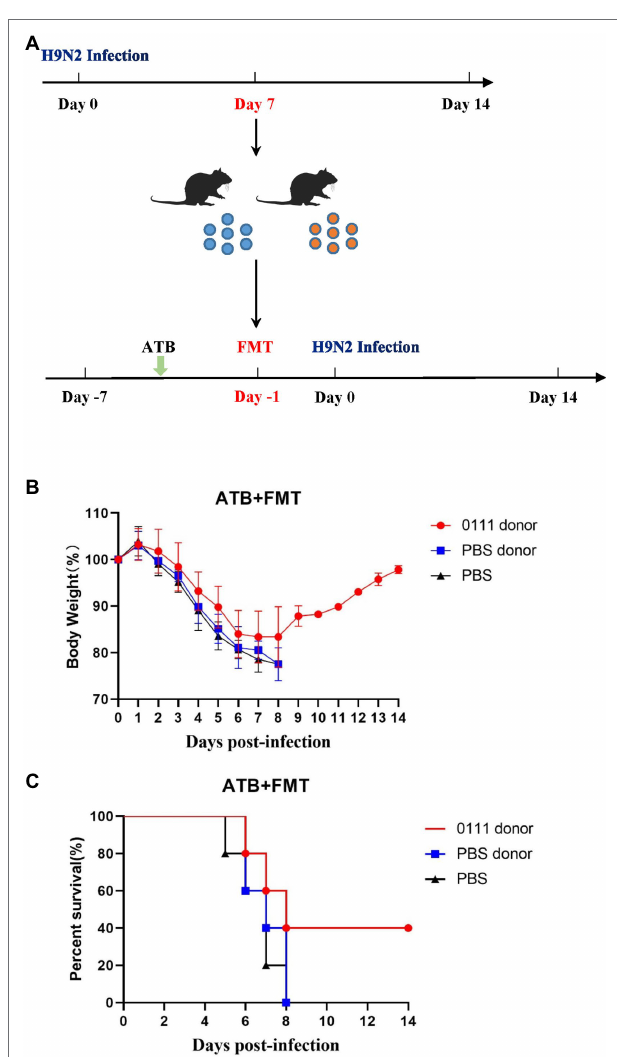
FIGURE 2 | FMT experiment. Mice feces were collected on day 7 after challenging H9N2 and FMT was performed 6 days after antibiotic treatment (A) . Mice ( N = 10/group) were challenged on day 0 and were observed for the next 14 days for infection. Body Weight in mice receiving FMT (B) . Survival rate of mice receiving FMT (C)